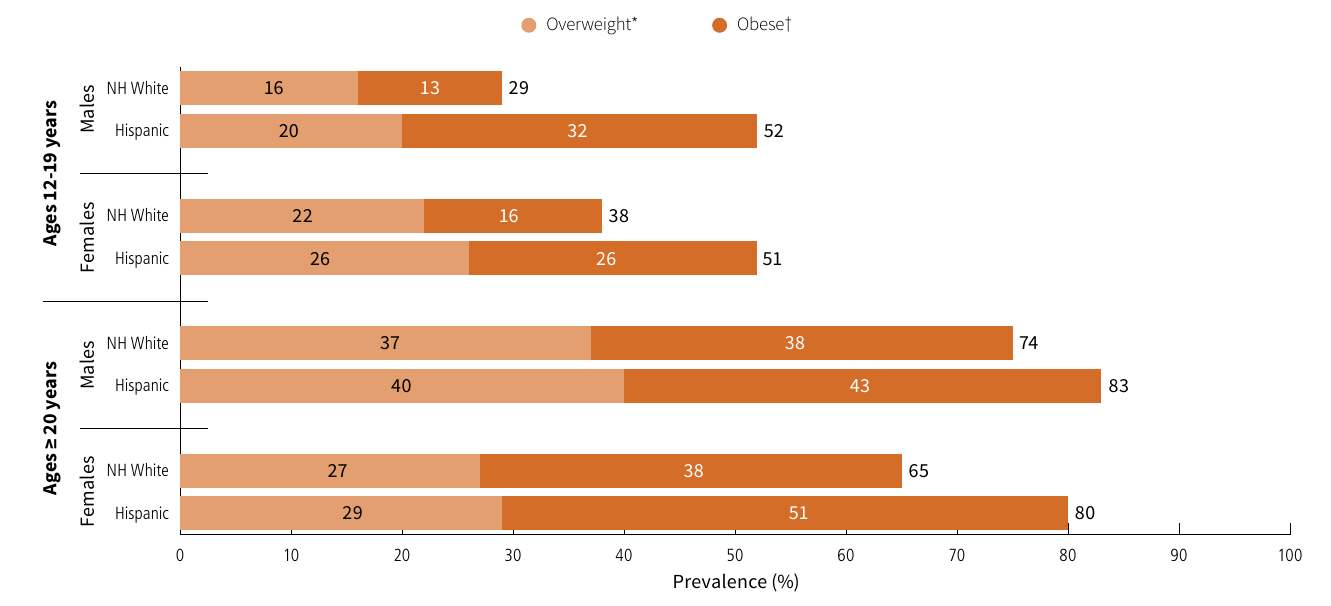
Figure 10. Excess Body Weight (%) in Hispanics and Non-Hispanic Whites by Age, US,